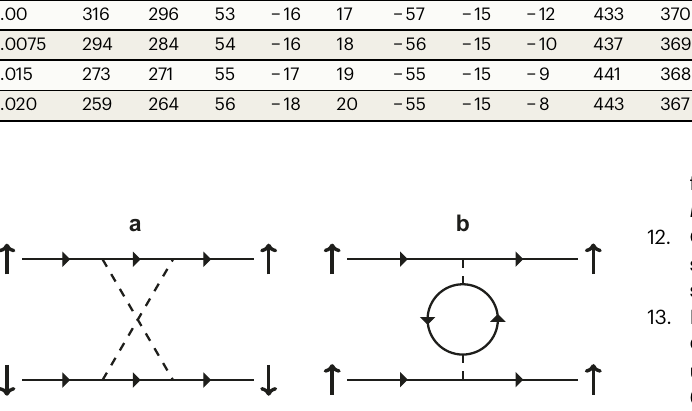
Table 1 | Tight-binding parameters. These parameters (in units of meV) were used for Eqs. (4), (5), (6), and (7), yielding Fig. 5a ∣ ε zz ∣